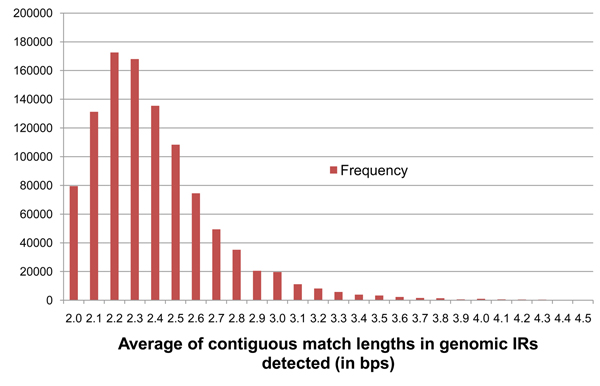
Frequency distribution of parameter A on genomic At IRs. Shows the frequency distribution of average contiguous match lengths (A) in IRs detected from genomic DNA of Arabidopsis thaliana with base thresholds of Dmin = 59% and Pmax = 9.99×10-9, Amin = 2.0, and Gmin = 19. The values of A for each pre-miRNA IR has been floored to the closest number with 1 decimal place.